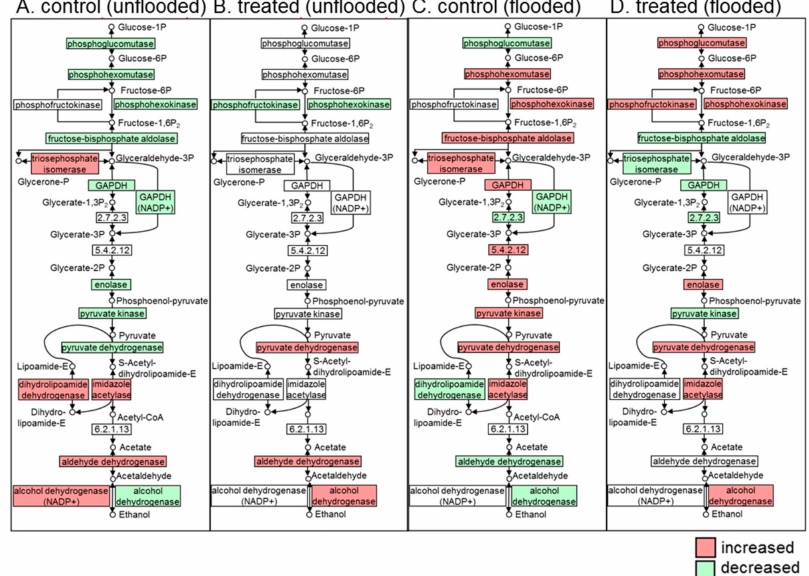
Figure 4. Mapping of di ff erentially changed proteins that related to glycolysis identified from root-hypocotyl tissue of irradiated (treated) / unirradiated soybean (control) during early seedling growth. Proteins were extracted from flooded and unflooded soybean seedlings. ( A ) Mapping from unirradiated soybean under unflooded conditions. ( B ) Mapping from irradiated soybean under unflooded conditions. ( C ) Mapping from unirradiated soybean under flooding. ( D ) Mapping from irradiated soybean under flooding. Proteins neither detected nor changed are marked in white. Abbreviations: GAPDH, glyceraldehyde 3-phosphate dehydrogenase. The number in the box indicates the enzyme commission number of corresponding proteins.